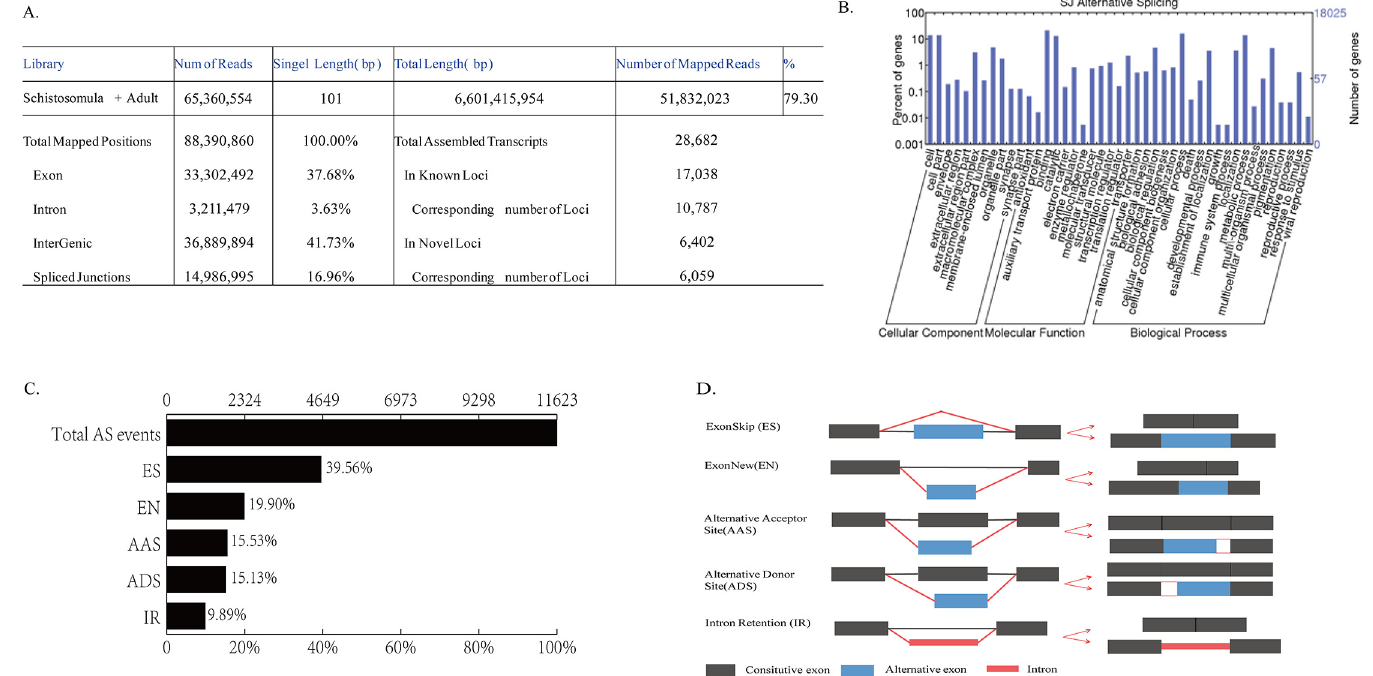
Fig 2. Analysis of RNA-seq data and alternative splicing in Schistosoma japonicum . A, Reads statistics in sheet form. In the mixed library, 65,360,554 reads with average length of 101 bp were detected. 79.30% of them were aligned with genome of Schistosoma japonicum . B, Gene Ontoloy annotation of alternative spliced genes in Schistosoma japonicum . C, Alternative splicing discovered in our data. ES: exon skip; EN: exon new; AAS: alternative acceptor site; ADS: alternative donor site; IR: intron retention. D, Annotation of five alternative splicing types in sketch.